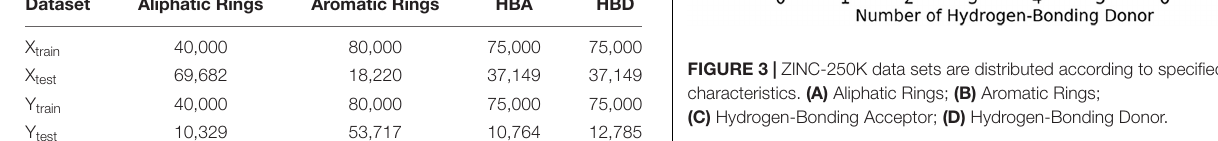
TABLE 2 | Structural transformations and dataset sizes. Dataset